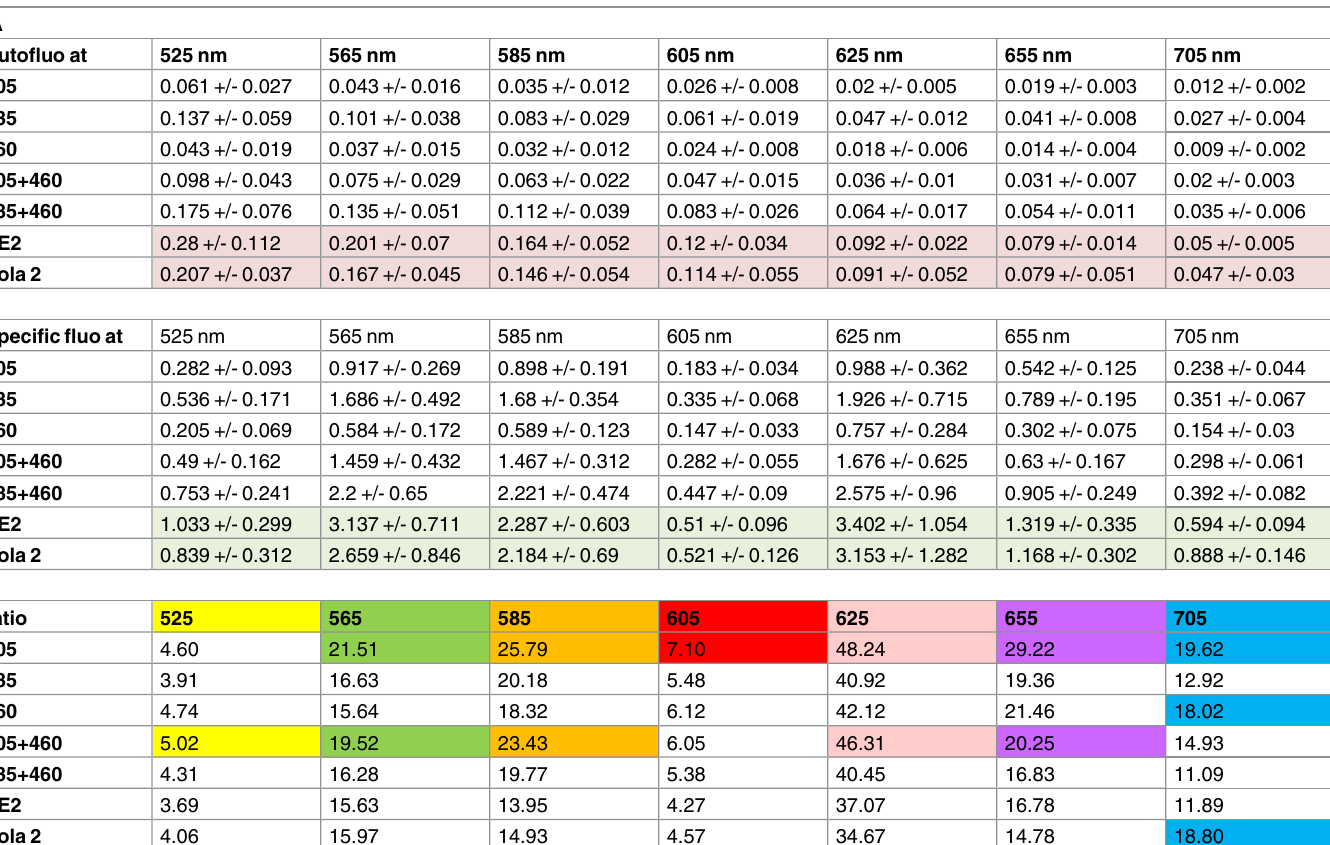
Table 5. Autofluorescenceand specificfluorescence